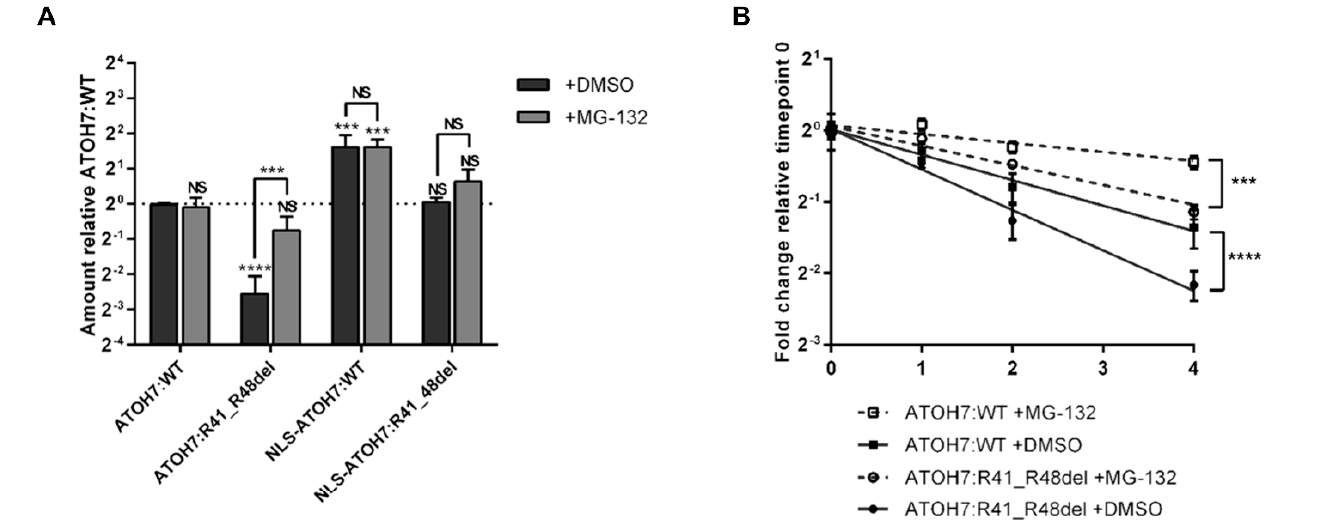
Figure 3. Decreased amount of the mutant ATOH7:R41_R48del protein is a result of increased pro- teasomal degradation. Plasmid constructs were expressed in HEK293T cells and cell lysates were subsequently analyzed by SDS-PAGE. ( A ) Semi-quantitative WB of V5-tagged ATOH7 normalized to β -tubulin and presented as fold-change relative to ATOH7:WT. The cells were treated with either DMSO or the proteasome inhibitor MG-132 for four hours before cell lysis. ( B ) CHX chase